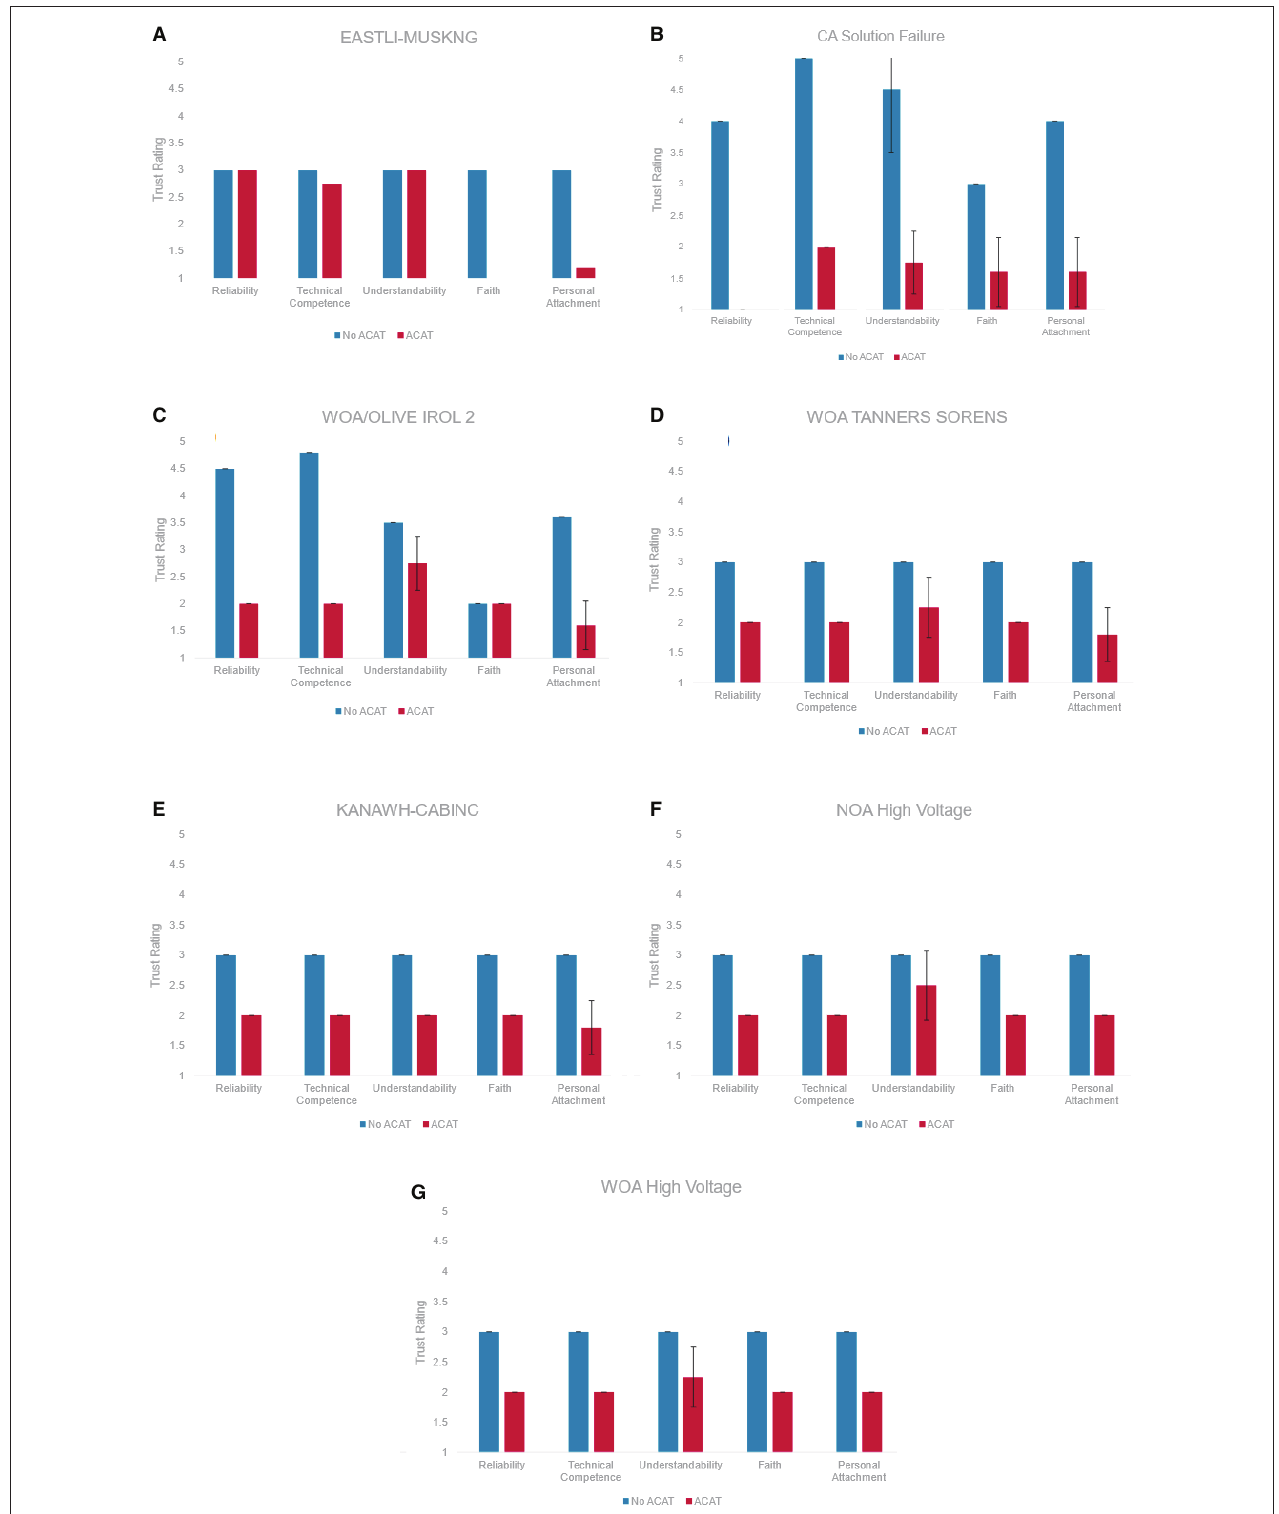
FIGURE 6 | Participant trust levels in both operational procedures (blue) and ACAT (red) for each of the seven scenarios (A) NOA EASTLI-MUSKNG, (B) SOA CA SOLUTION FAILURE, (C) WOA OLIVE IROL 2, (D) WOA TANNERS-SORENS, (E) SOA KANAWH-CABINC, (F) NOA LIGHTLOAD-HIGHVOLT, and (G) WOA